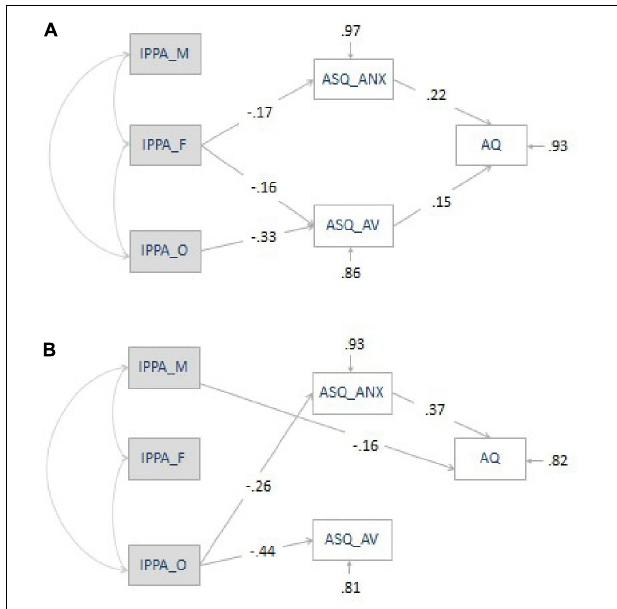
FIGURE 2 | (A,B) Final path analytical models of the effects of parent/peer attachment (IPPA) and anxiety/avoidance dimensions of attachment style questionnaire (ASQ) on aggression questionnaire (AQ) in adolescent boys (A) and girls (B) . Coefficients are standardized structural coefficients. All coefficients are significant at least above the p < 0.05 level. Maternal attachment (IPPA_M) did not have any significant causal relationships with any other variable in model (A) . Paternal attachment (IPPA_F) did not have any significant causal relationships with any other variable in model (B)